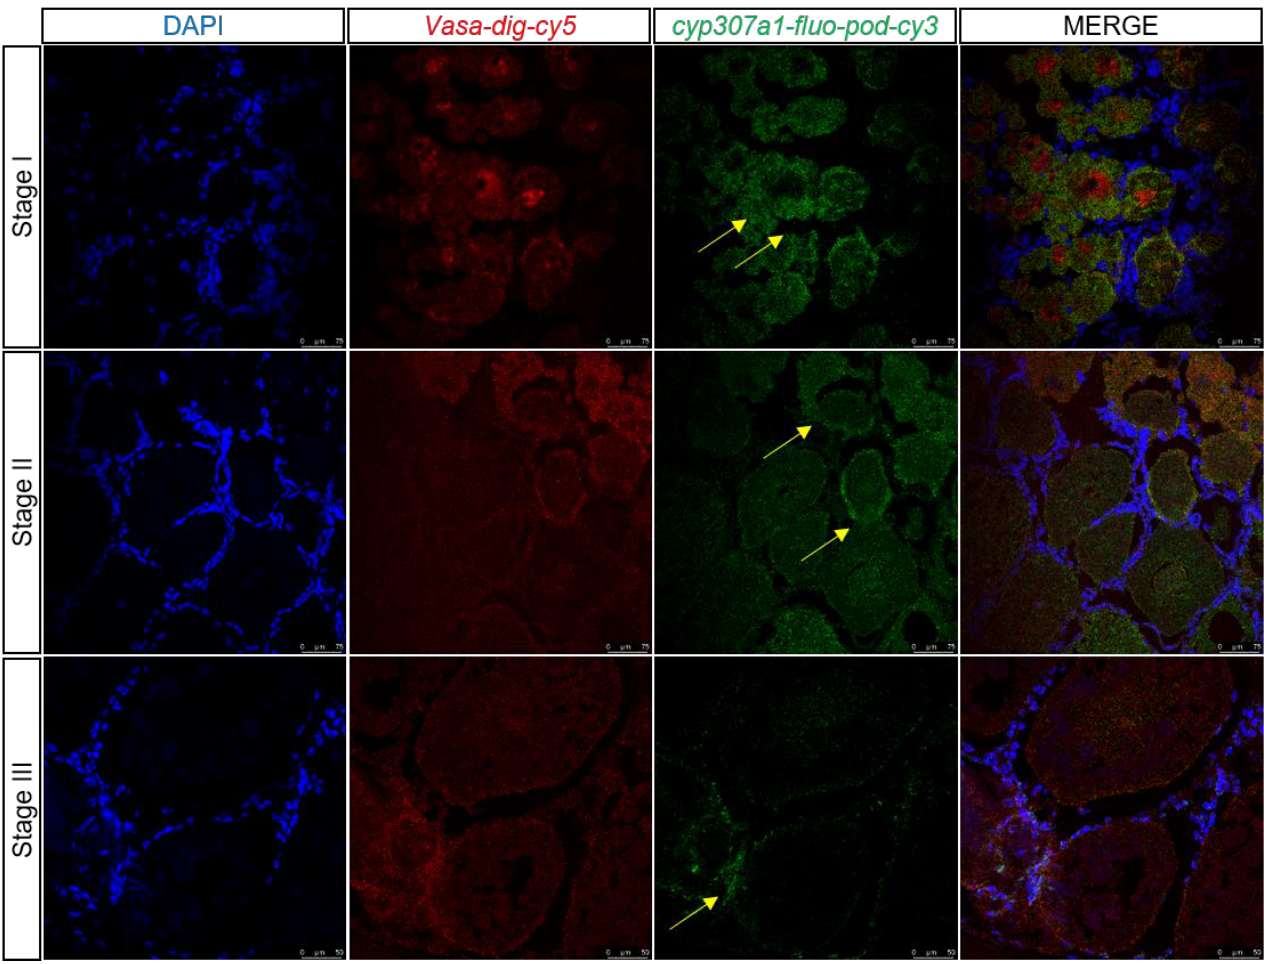
Figure 10. Two-color fluorescent in situ hybridization showing expression profiles of cyp307a1 and vasa in the ovary at different stages (scale, Stage I, II: 75 μm; Stage III: 50 μm). Blue signal: DAPI; red signal: vasa ; and green signal: cyp307a1 . The yellow arrow marks the green signal.